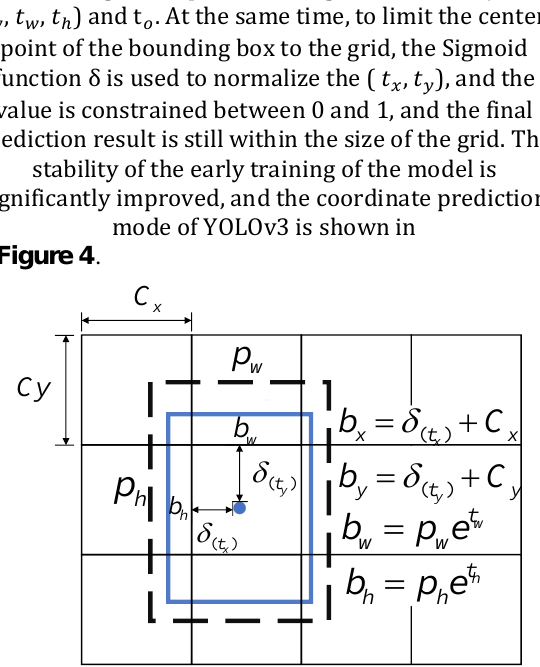
Figure 4 The coordinate prediction mode of YOLOv3